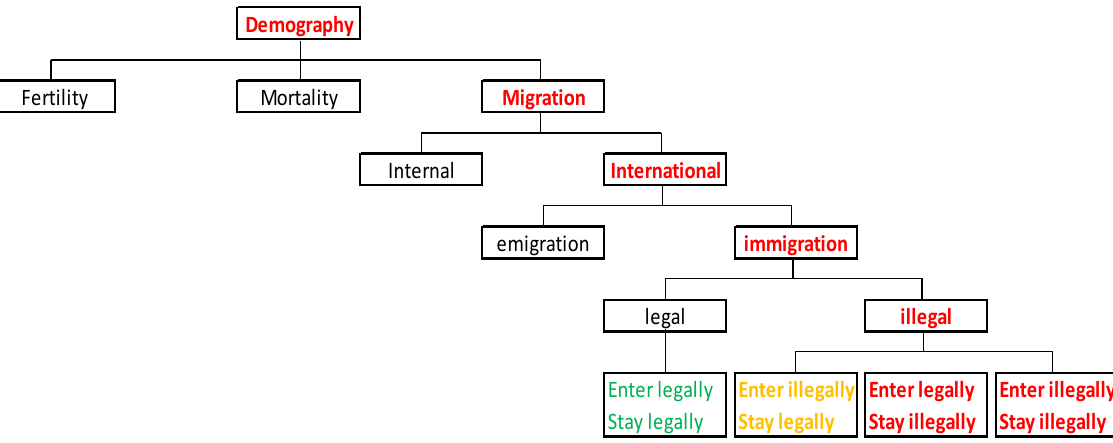
Figure 2: The three components and subcomponents of demography with migration, international migration, immigration